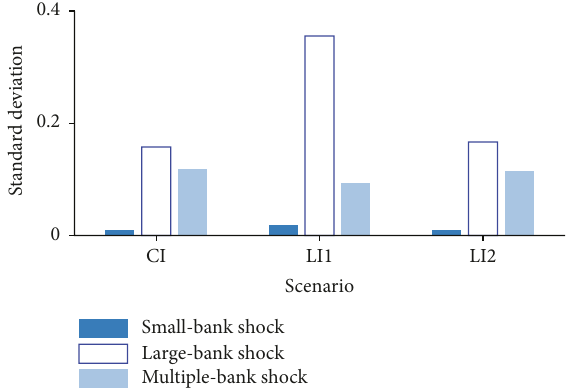
Figure 12: The impact of exogenous manipulation of con fi dence C on the level of total assets ( A ) in the system. Two applied manipulations of C follow normal distribution with the same [derived from the complete mean and di ff erent variances: V CI i information (CI) scenario] and V LI1 [derived from the local i information (LI) LI1 scenario]. The higher variance corresponds to the faster decline of total assets in the system. CI is a scenario in which a bank has access to information from all other banks in the network. LI1 is a scenario in which a bank has access only to information from banks at distance